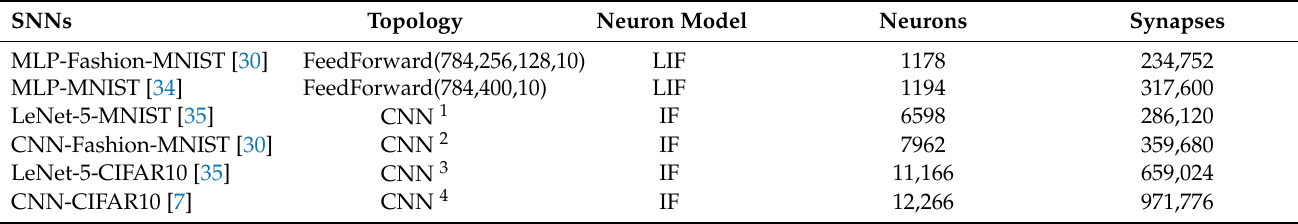
Table 1. The SNN-based applications used to evaluate our